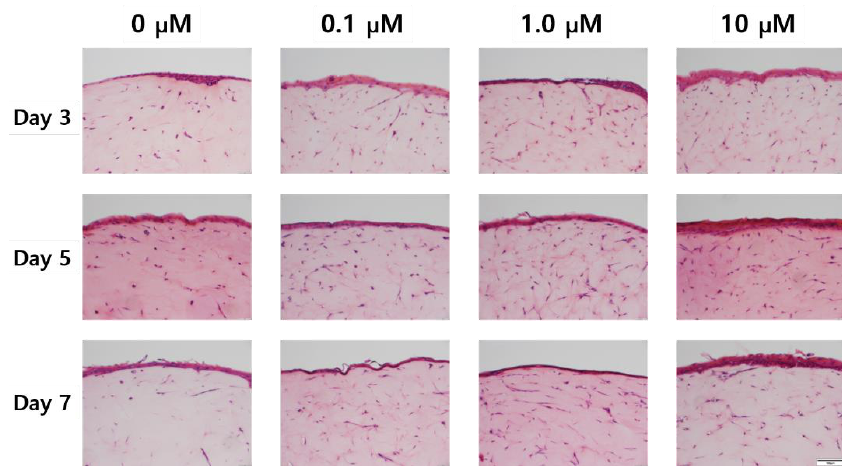
Figure 5. Hematoxylin & eosin staining images of the sample with air exposure and coenzyme Q10 concentration (bar = 100 μ m).